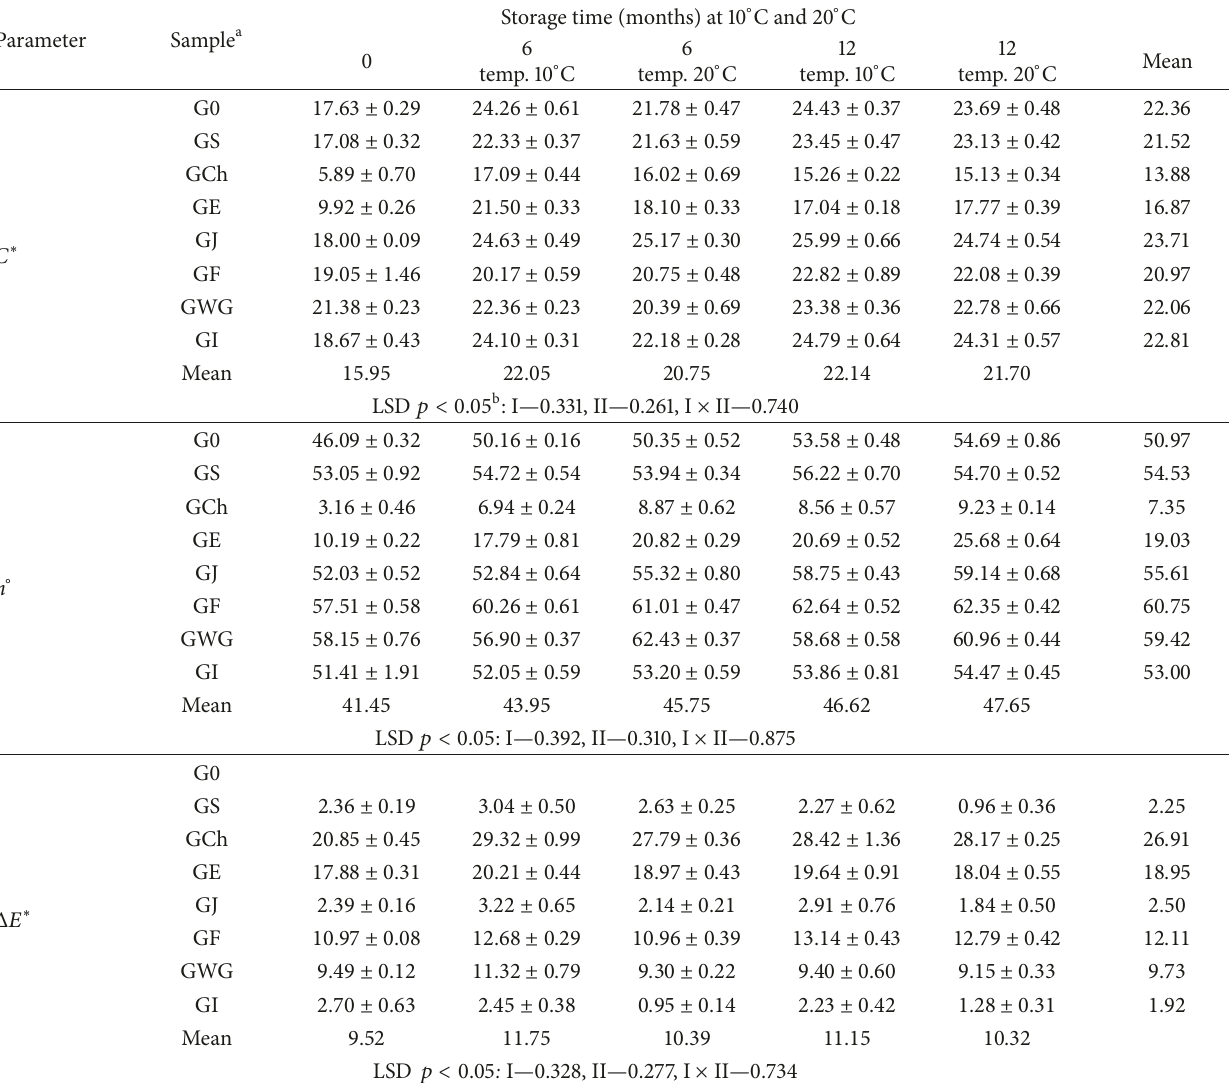
Table 4: Changes in chroma ∗ (𝐶 ∗ ) , hue angle ∗ ( h ∘ ), and color change (Δ𝐸 ∗ ) of gooseberry jams during storage in 10 ∘ C and 20 ∘ C.